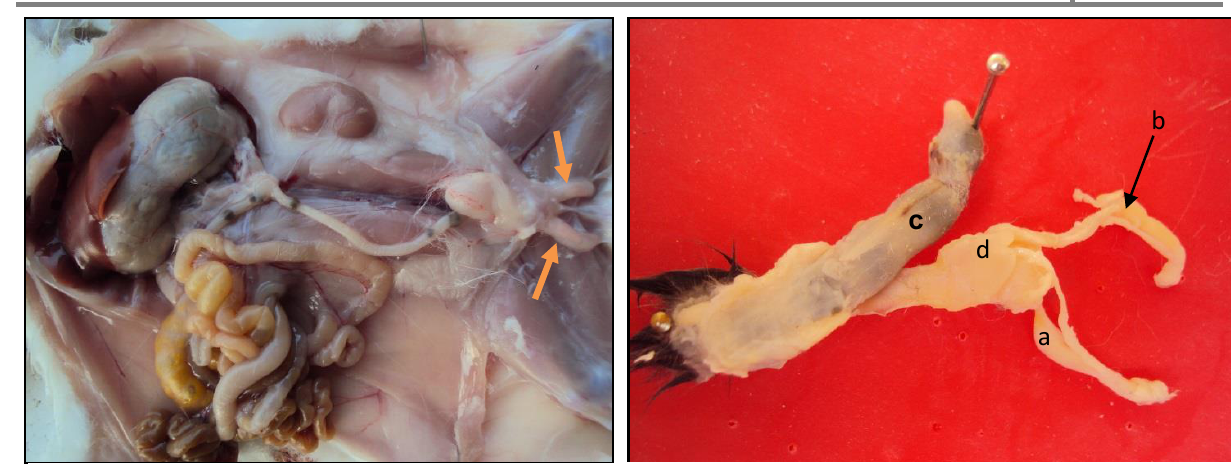
Figure, 6:Reproductive organs of the Kit rabbit at 30- days age, shows the shape of the testes a-testis b- epididymisc- rectum d- seminal vesicle gland.